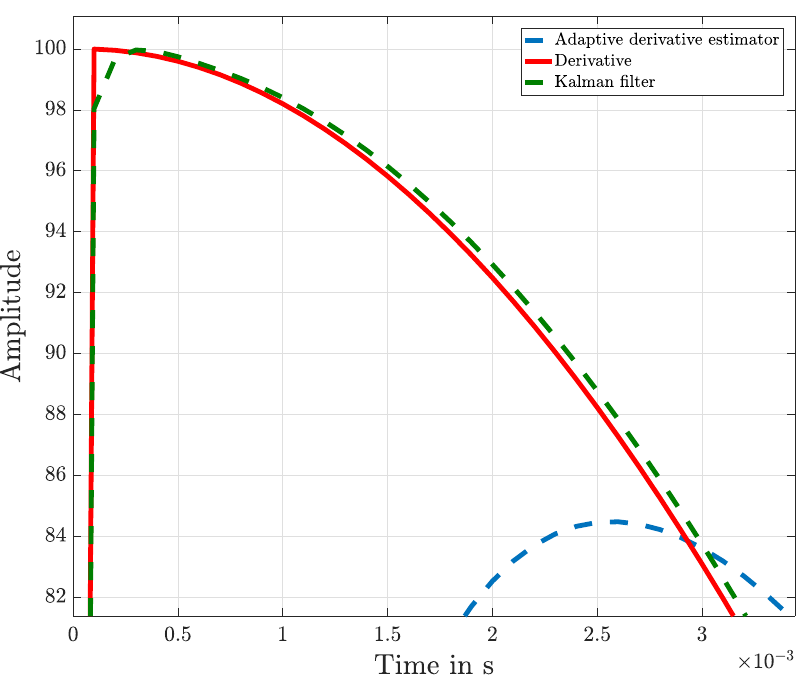
Figure 4. Detailed representation of Figure 3 and its estimations.